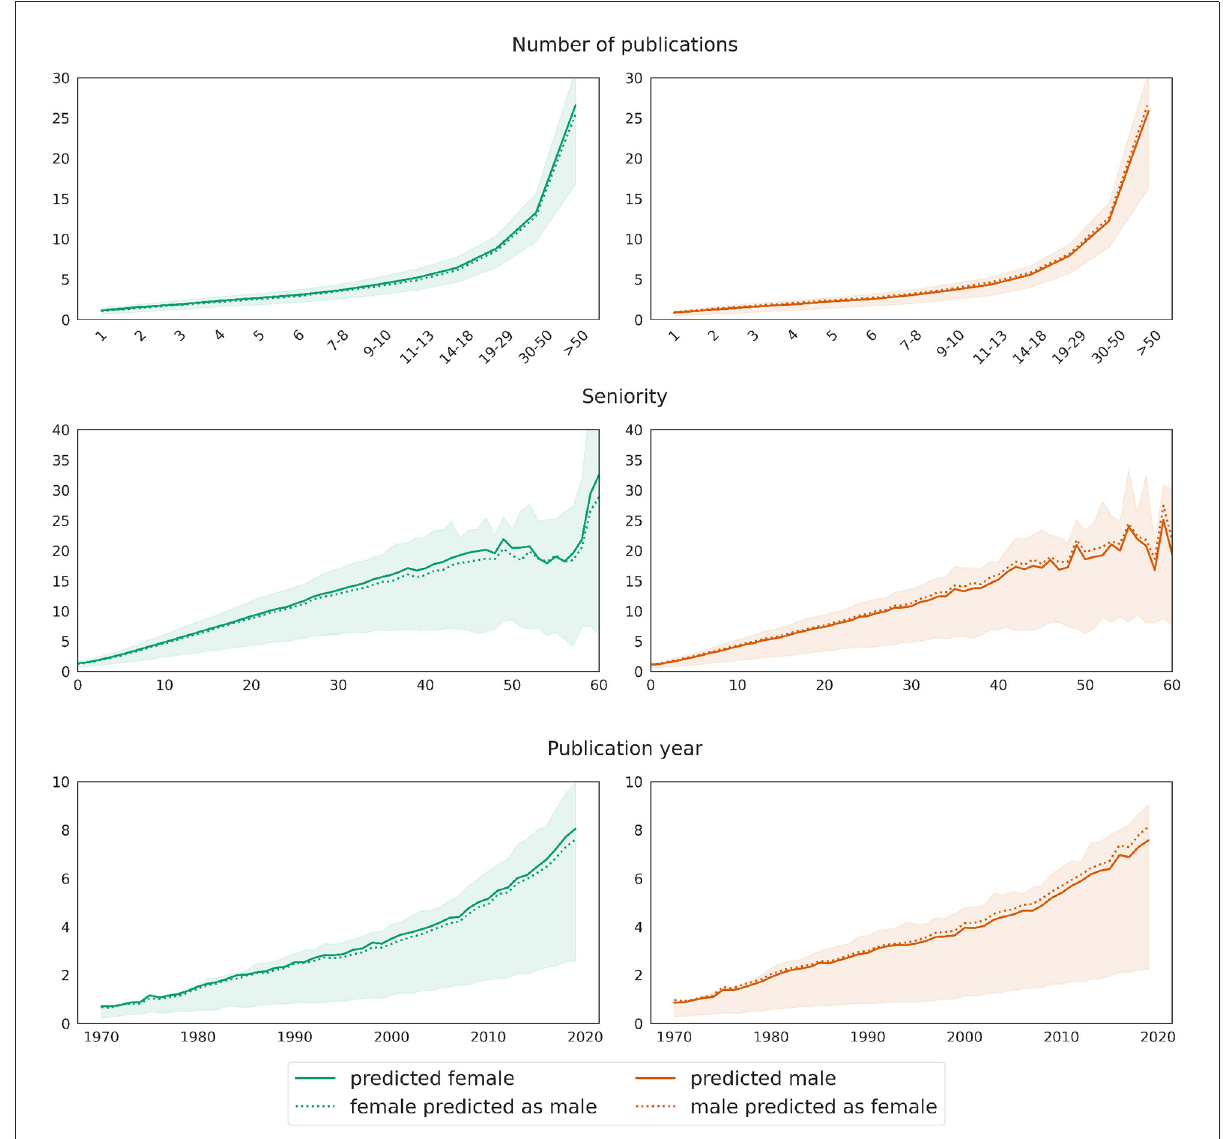
FIGURE8 Gender swapping approach: deviations in the value distributions of predictions applied to real data (solid curves) and data with swapped gender values (dotted curves) for the target variable network size . The curves show mean values, while shaded areas mark the [25,75] confidence interval of the predictions on real test